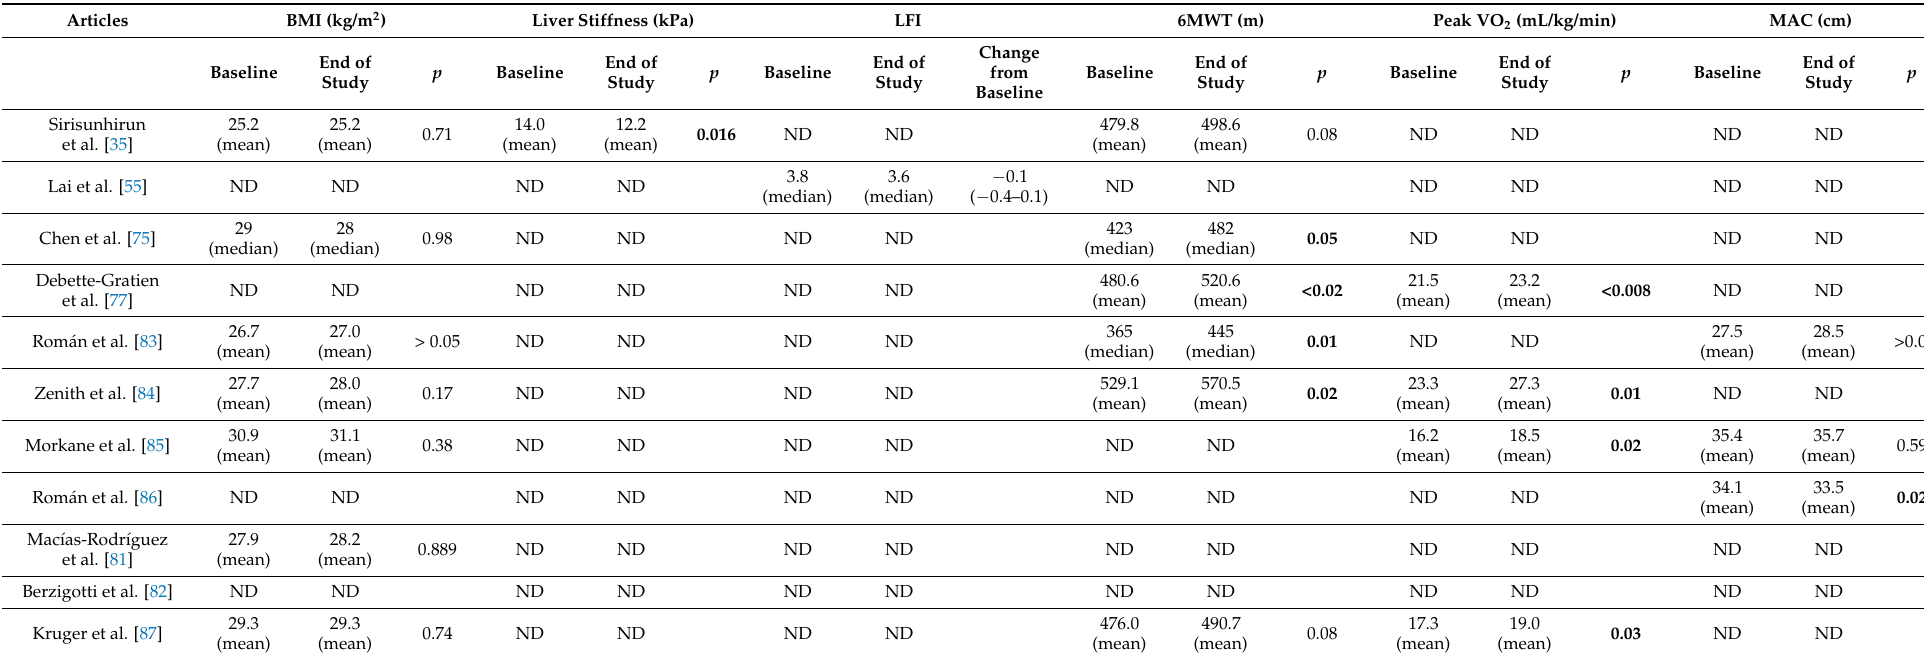
Table 2. Outcomes in studies on interventional physical exercise programs in patients with